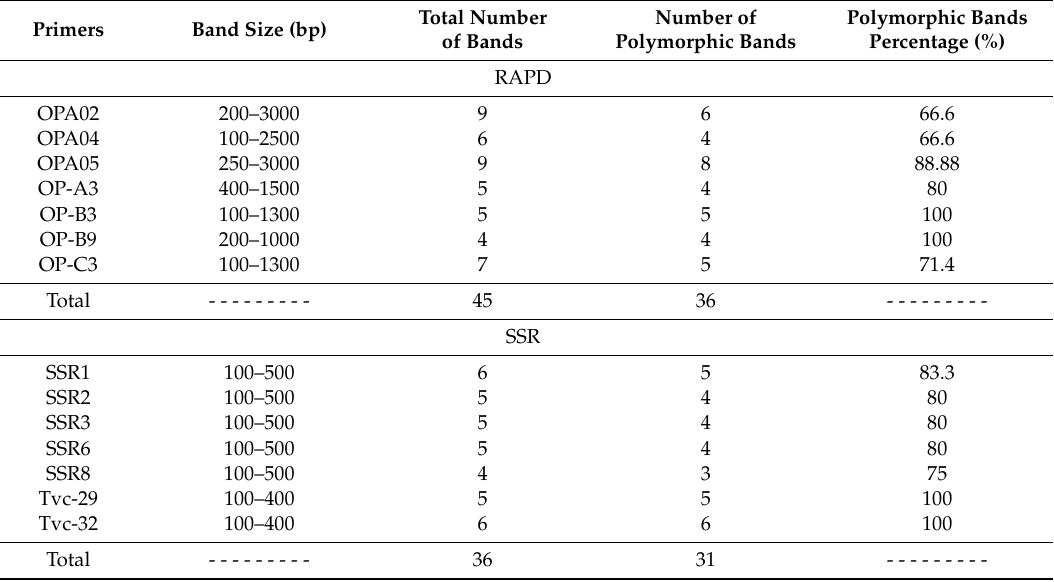
Table 2. RAPD and SSR-PCR analysis of Trichoderma